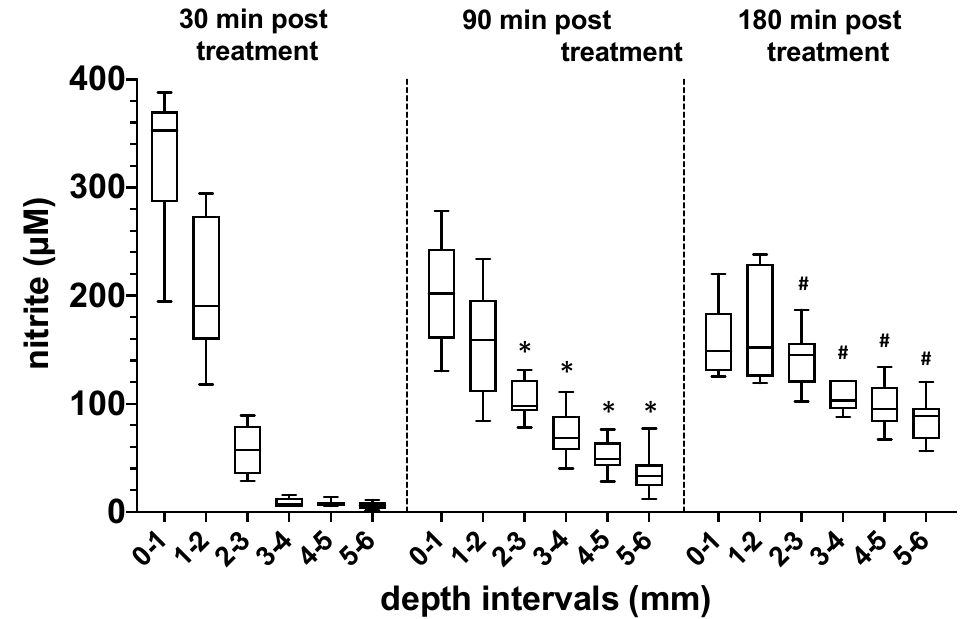
Figure 4. Evaluation of the depth of penetration of nitrogen oxide derivatives into bone tissue after exposure to plasma. Quantification of the nitrite content ( μ M) at different depths of human bone samples treated with DBD plasma (5 min at 410 mW power dissipation in the discharge). Values from 5 individual ( n = 5) experiments are presented as a boxplot with median and with whiskers with minimum and maximum. The nitrite content in the bone samples was detected 20, 90 and 180 min after plasma exposure using CLD technology. *, p < 0.05 as compared to corresponding values detected after 20 min. # , p < 0.05 as compared to corresponding values detected at 20 or 90 min.